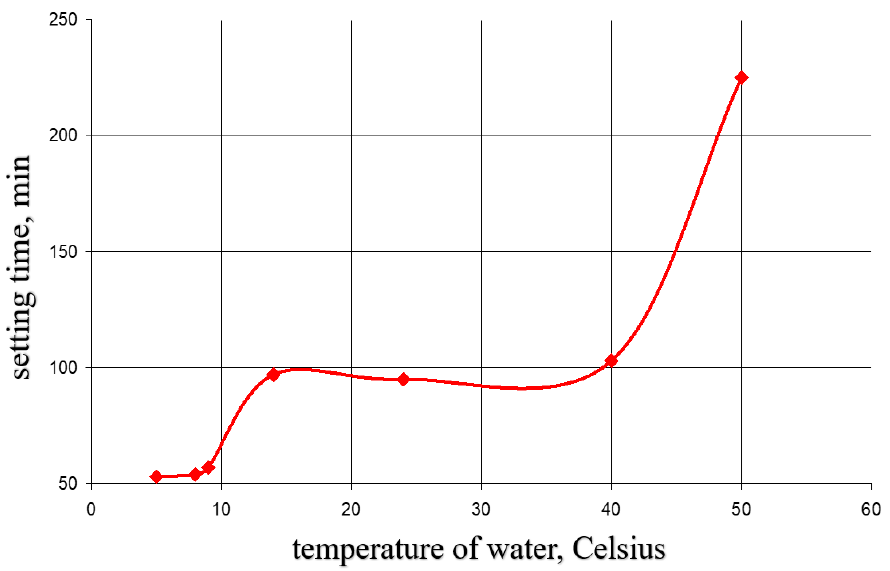
Figure 3. The dependence of the end of anhydrite binder setting on the temperature of the mixing water.